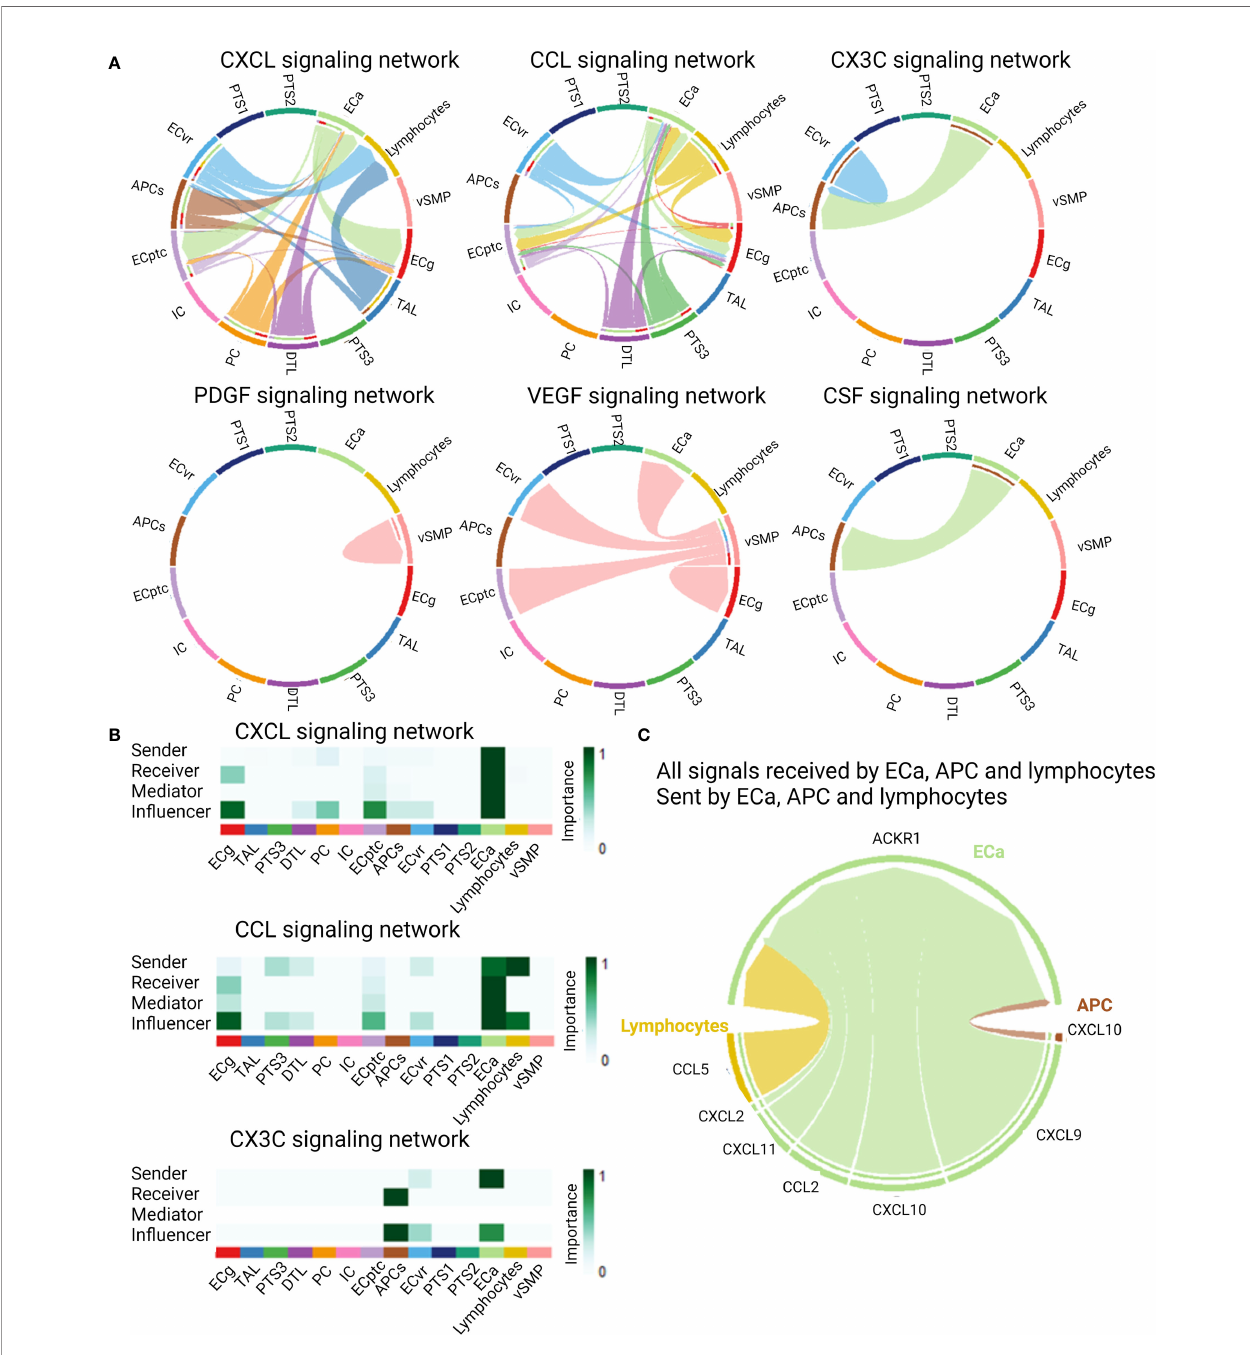
FIGURE 4 | Cell – cell communications derived from scRNASeq data of kidney allograft biopsies. (A) Cytokine and chemokine signaling pathways that were signi fi cant communication pathways in the kidney allograft cells. (B) Most important senders, receivers, mediators, and in fl uencers of the CXCL, CCL, and CX3C signaling network. (C) Circos plot demonstrating all signals received by activated endothelial cells (ECa), sent by activated endothelial cells, antigen-presenting cells (APCs), and lymphocytes, illustrating the ligand – receptor